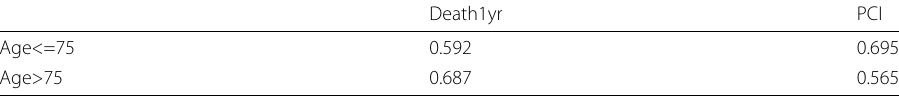
Table 13 Average F-score in 2007-2011 of GBDT on groups divided by age